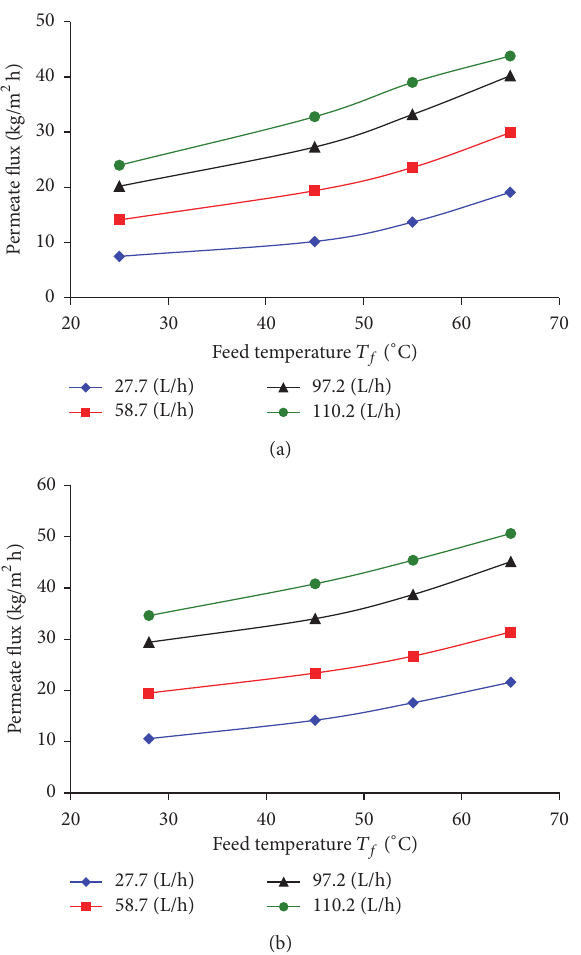
Figure 7: The effect of the feed temperature on the permeate flux through (a) PVDF and (b) PTFE membranes at different feed flow rates, with 97 kPa vacuum degree and feed concentration of 35,000 mg/L.